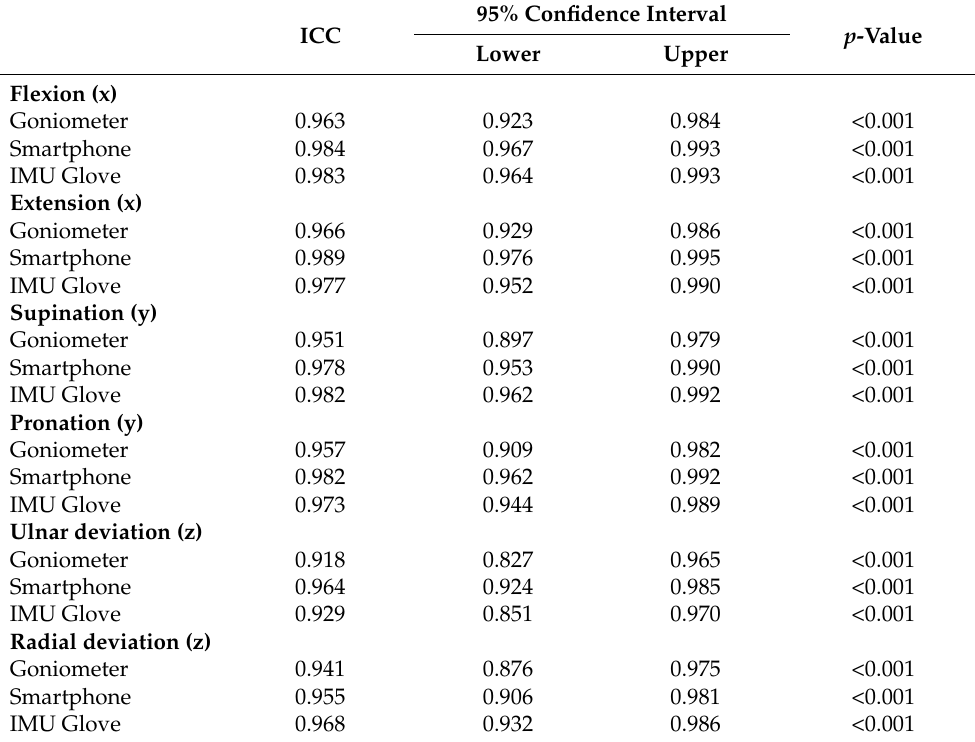
Table 3. Intraclass correlation coefficient for the three operators who performed the